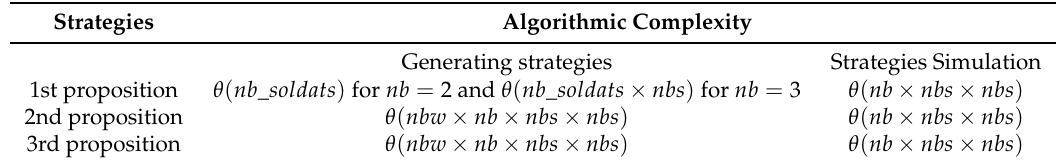
Table 3. Complexities of the algorithms of the proposed strategies.